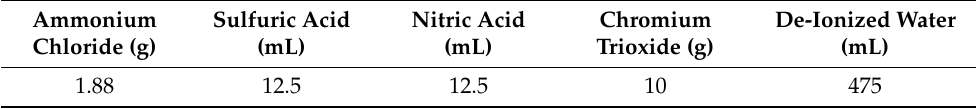
Table 2. Composition of etching solution used in this